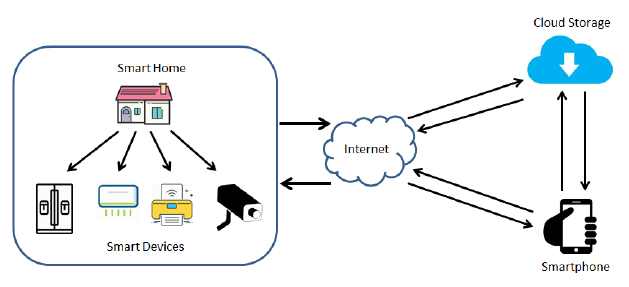
Figure 2. Architecture of IoT (Smart Home